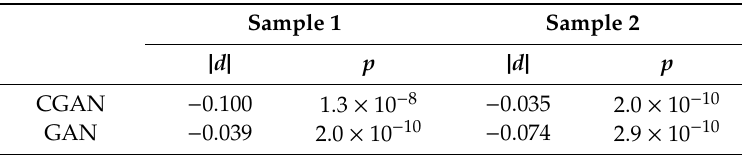
Table 8. Best obtained absolute difference and p value calculations for robust equivalency testing when comparing targeted generation of data using CGAN and GAN on DS3. Both CGAN and GAN were trained using Wasserstein Gradient Penalty loss.